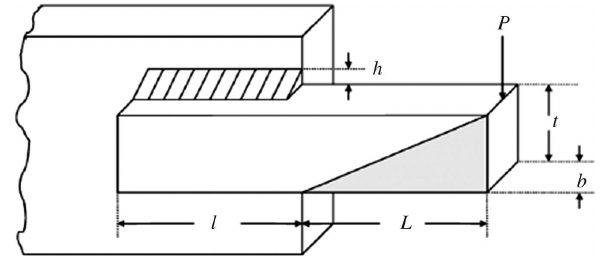
Figure 2: Welded Beam Design